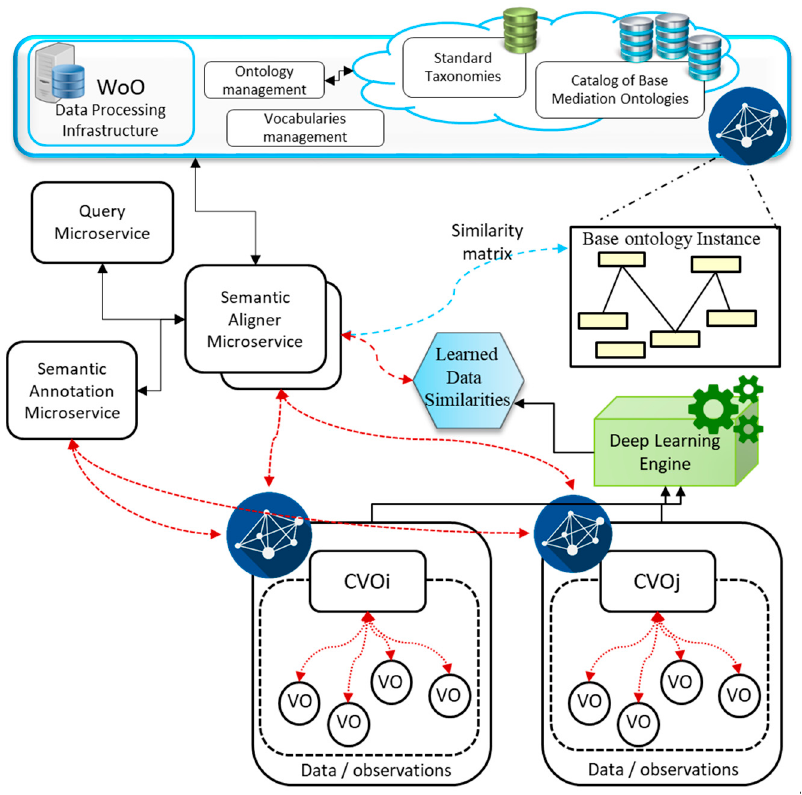
Figure 11. Semantic interoperability processing with the base ontology catalog.